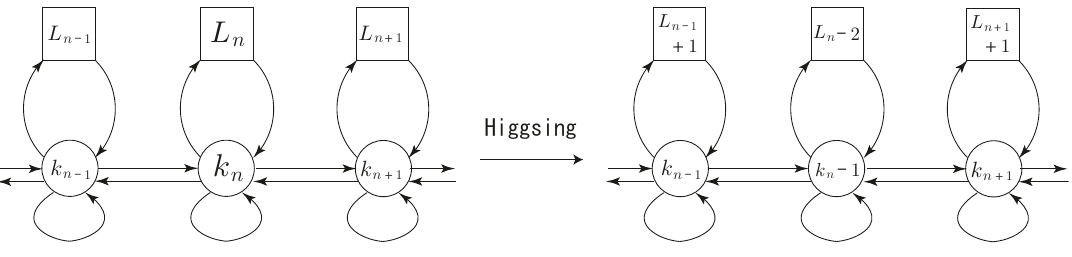
Figure 5 . Higgsing the n -th gauge node of the A M linear